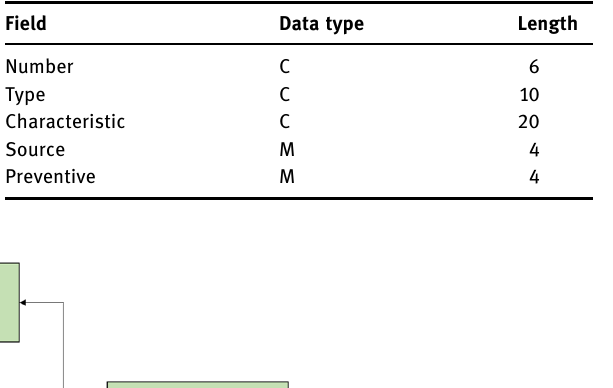
Table 1: Table structure of control and data fl ow class